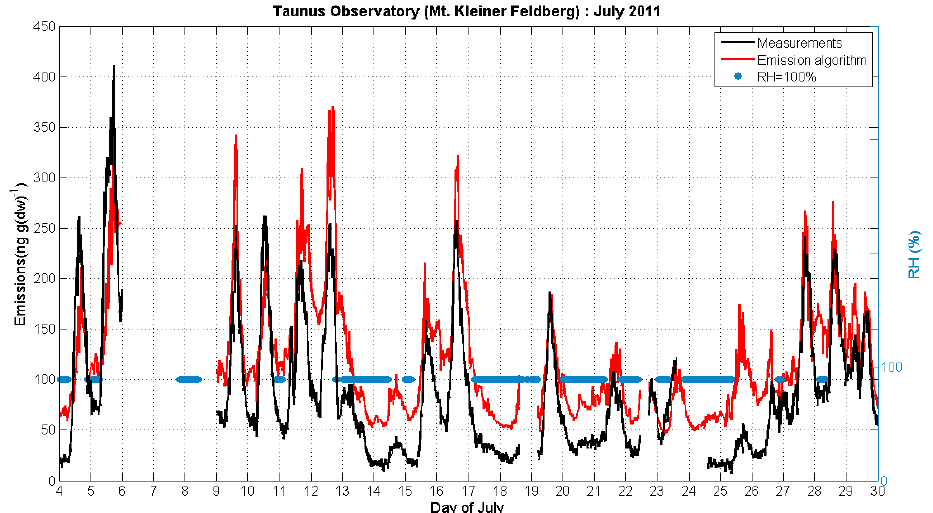
Fig. 9. Example of how RH can influence SQT emission rates. In case of RH = 100%, the algorithm fails, since the thin water layer created above the needle surface acts in protective way for the involved